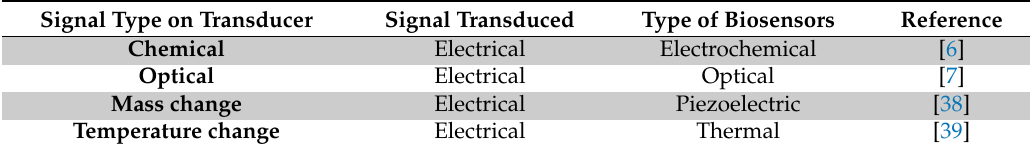
Table 1. Types of biosensor based on transducers/signals